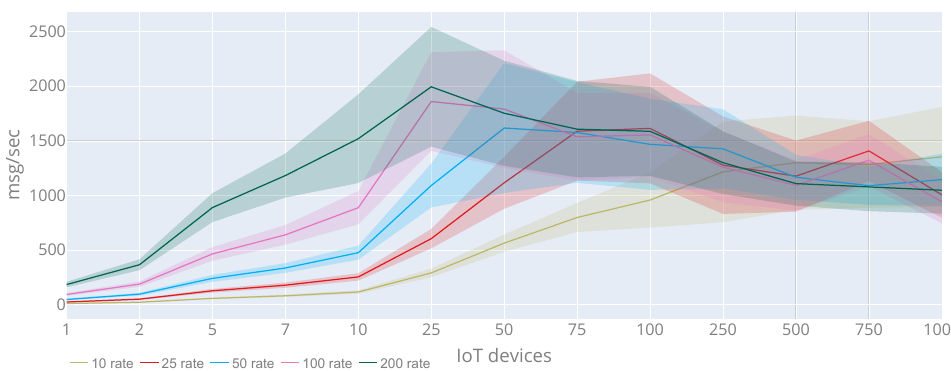
Figure 14. Average and standard deviation throughput of the observations injection with rates of 10, 25, 50, 100 and 200 requests per second.